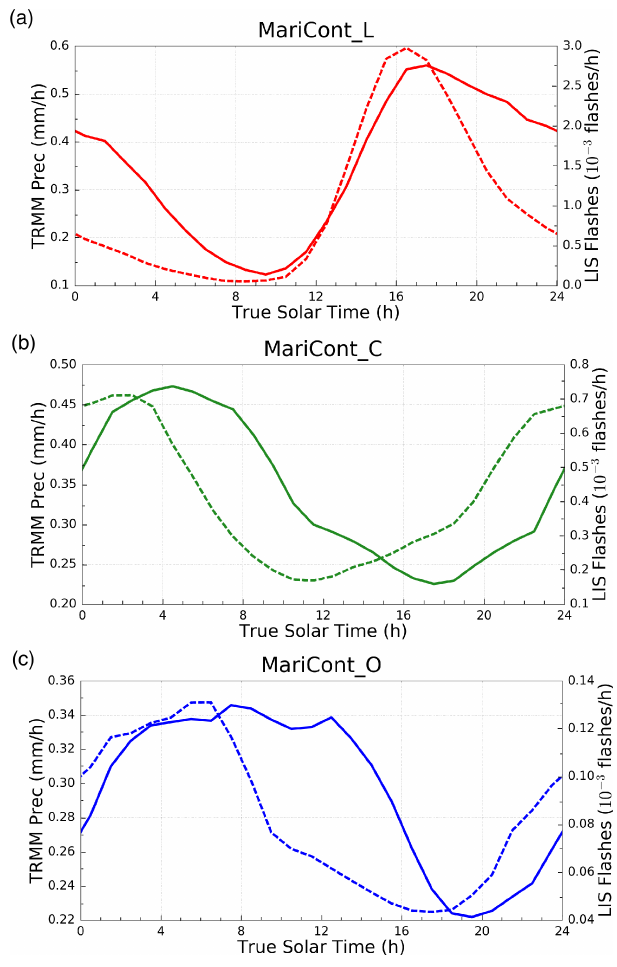
Figure 7. Diurnal cycle of Prec (solid line) and diurnal cycle of Flash (dashed line) over MariCont_L (a) , MariCont_C (b) and MariCont_O (c)